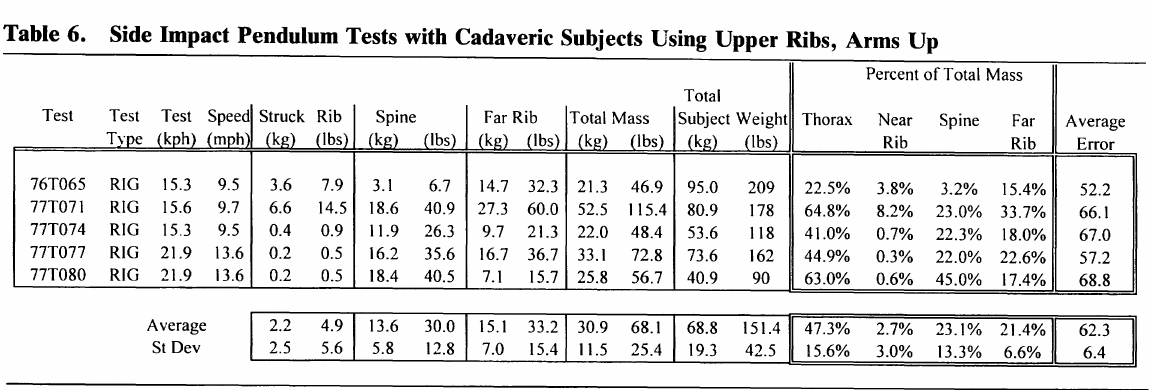
Table 6. Side Impact Pendulum Tests with Cadaveric Subjects Using Upper Ribs, Arms Up